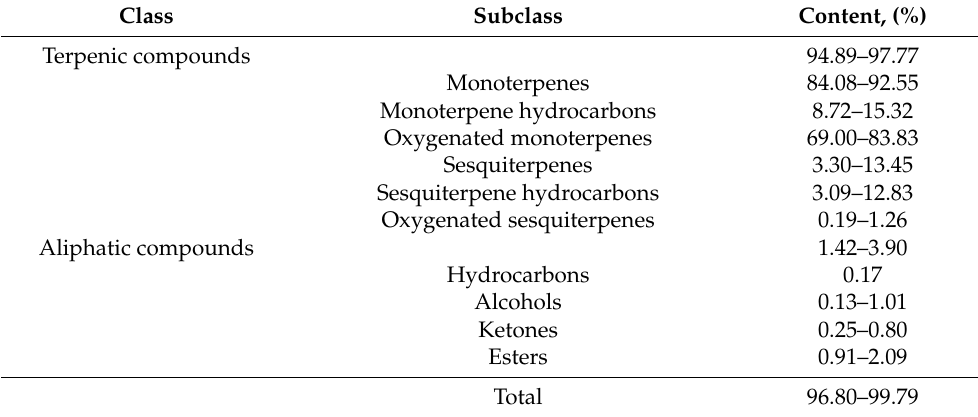
Table 2. Chemical composition of lavender essential oil.